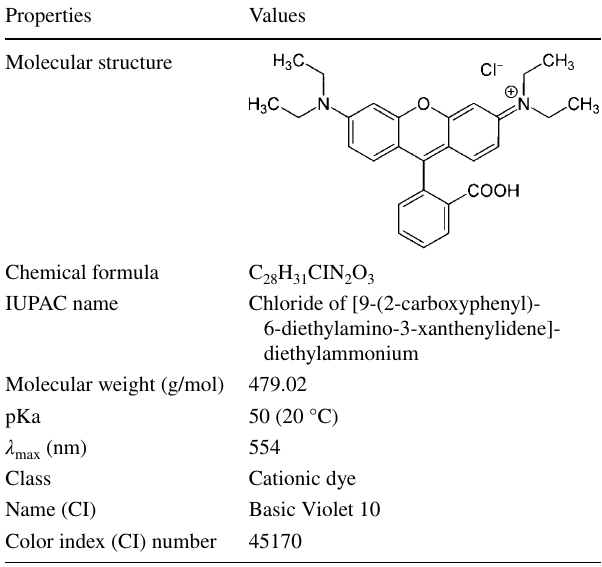
Table 1 Physicochemical properties of Rhodamine